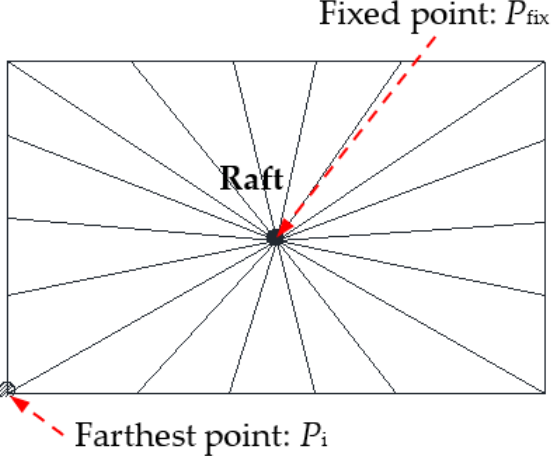
Figure 4. "Cast net" search method.